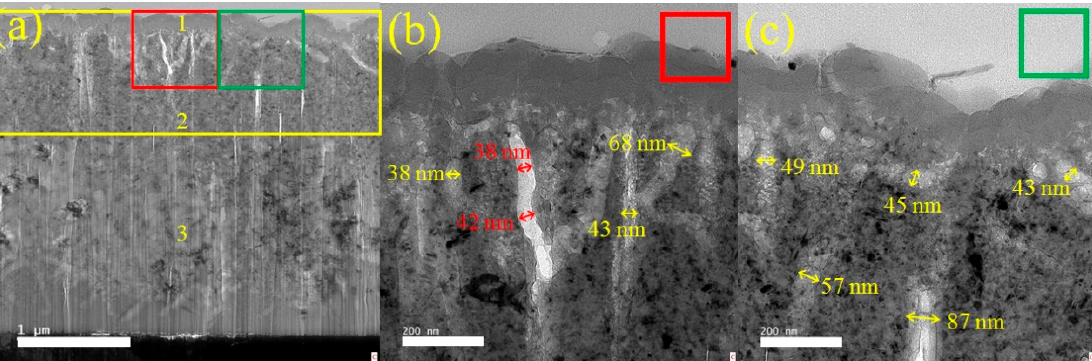
Figure 6. The TEM cross-section images of nano-porous poly-Si absorption films, ( a ) entire thickness ( b ) red region, and ( c ) green region, after 1500 s Ag-NPS induced etching. ( b ) red region, and ( c ) green region, after 1500 s Ag-NPS induced